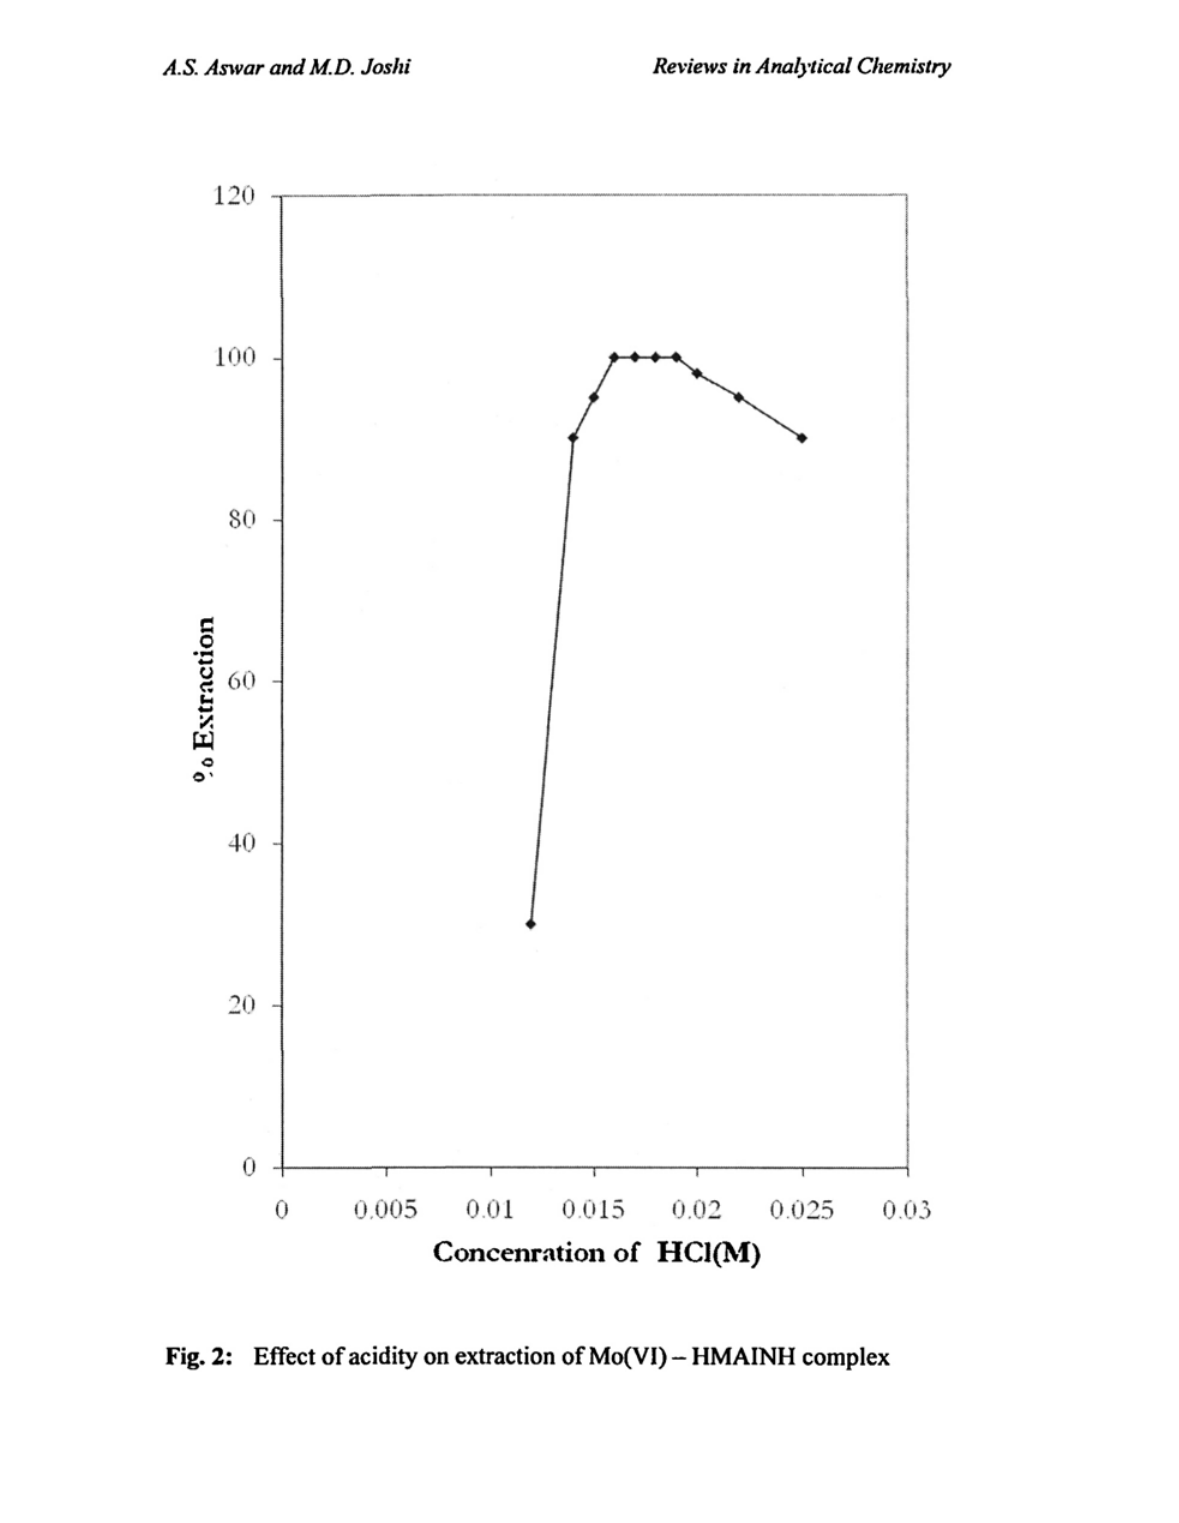
Fig. 2: Effect of acidity on extraction of Mo(VI) - HMAINH